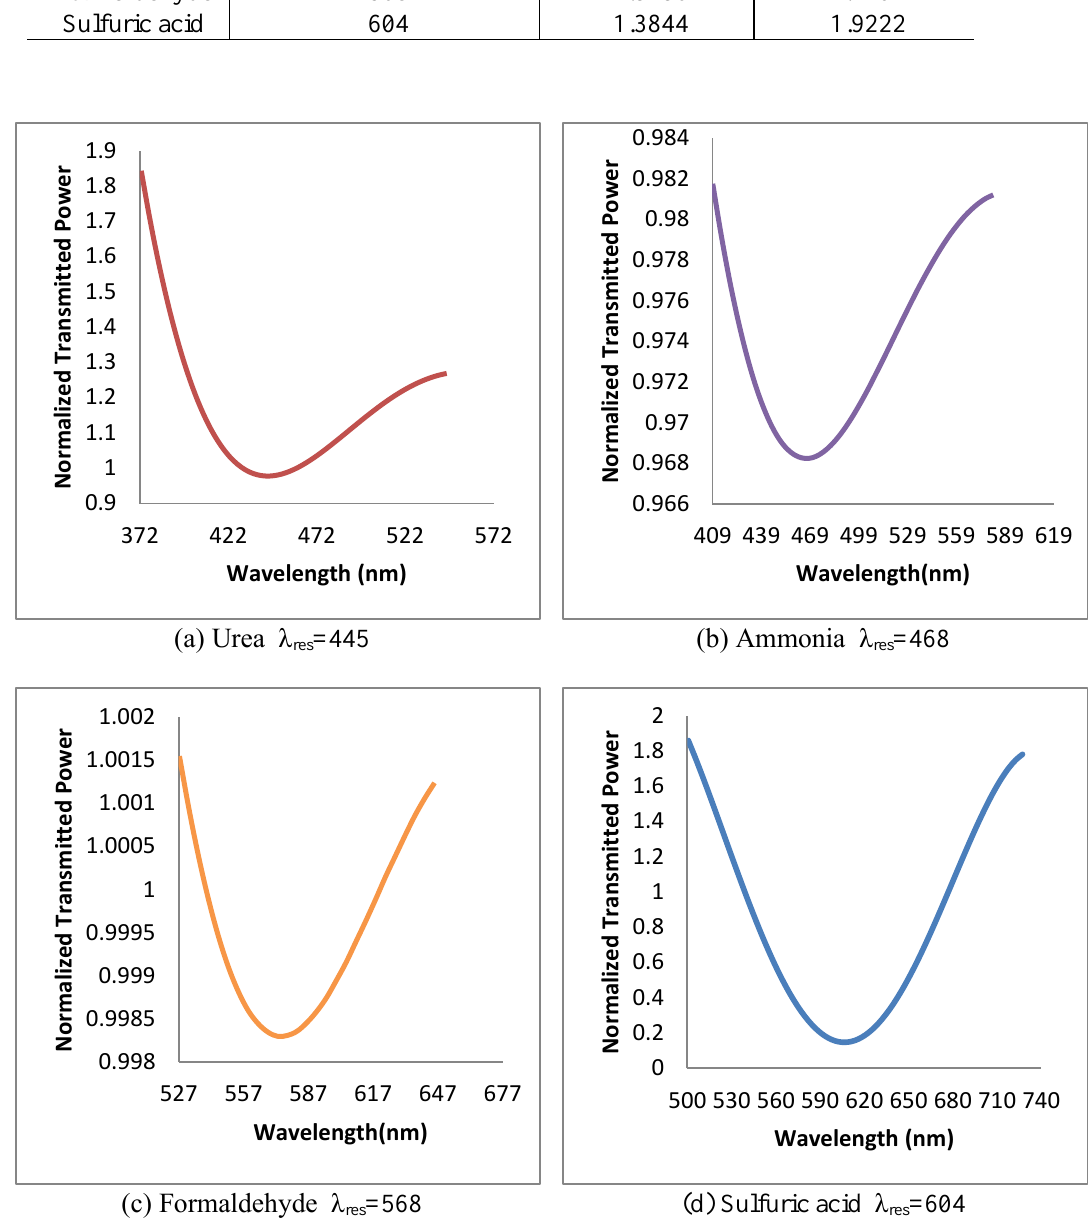
Figure 7: SPR curve of the optical fiber sensor with multi-layer metal (aluminum/gold) for different samples of chemical: (a) Urea, (b) Ammonia, (c) formaldehyde, and (d) Sulfuric acid.